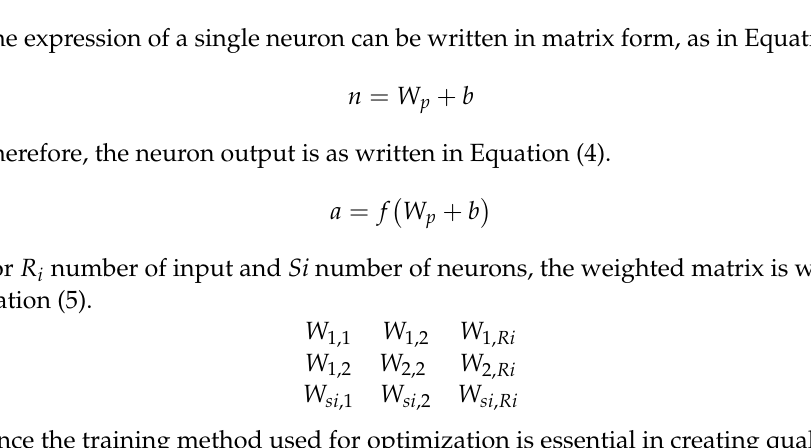
Figure 15. Activation function. Multiple input neurons have individual inputs P 1 , P 2 , P 3 ....P RI weighted by W 1 , 1 , W 1 , 2 , W 1 , 3 ....W 1 , RI and formed a weight matrix W . The neuron